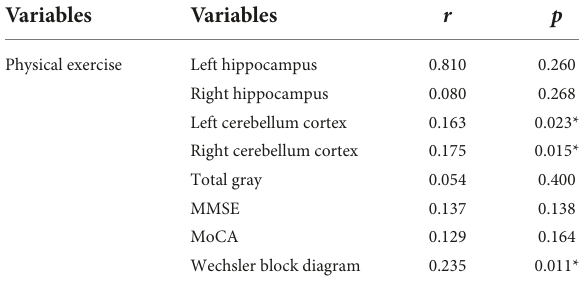
TABLE 3 Correlation between physical exercise and brain structure and cognitive